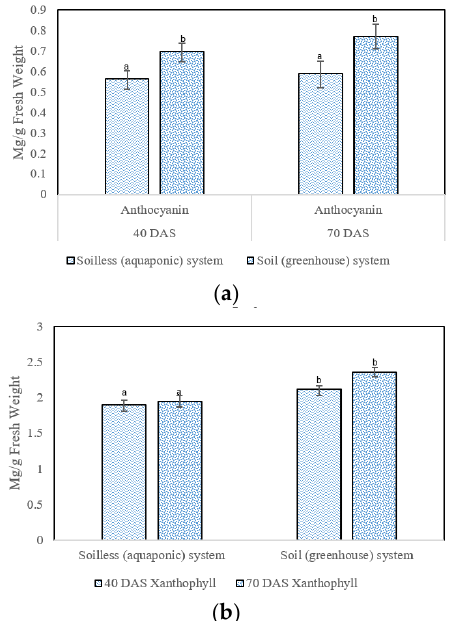
Figure 3. Anthocyanin ( a ) and xanthophyll ( b ) concentrations of Ocimum basilicum in (aquaponic) and soil (greenhouse) systems at 40 and 70 DAS. Values are given as mean ± SD of seven samples in each group. Values that do not share a common superscript (a, b) differ significantly at p ≤ 0.05 using t test.